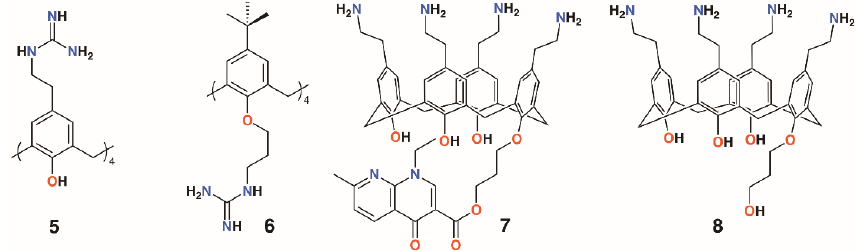
Figure 4. Regnouf-de-Vains’ soluble guanidinium-functionalized calixarenes.